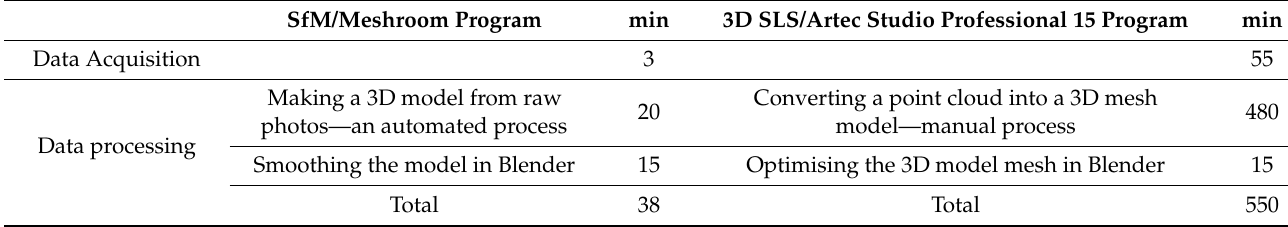
Table 7. Time-consuming production of 3D models of the furnace using the SfM and 3D SLS methods.